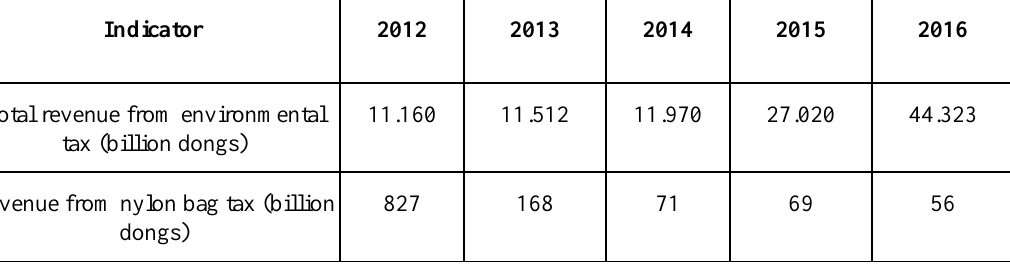
Table 3. Environmental tax revenue in 2012-2016 (Financial Times,